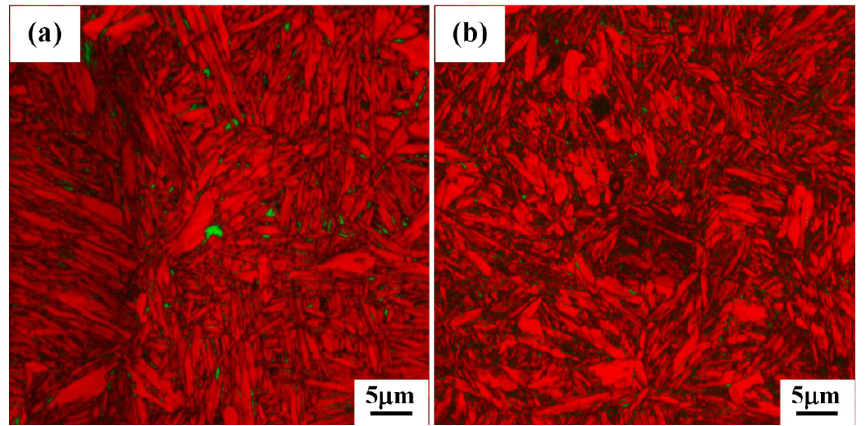
Figure 13. EBSD images of specimens held at ( a ) 250 °C and ( b ) 200 °C for 1 h isothermal holding. The RA is shown in green and the bainite and martensite are the bright and dark red-colored regions, respectively.